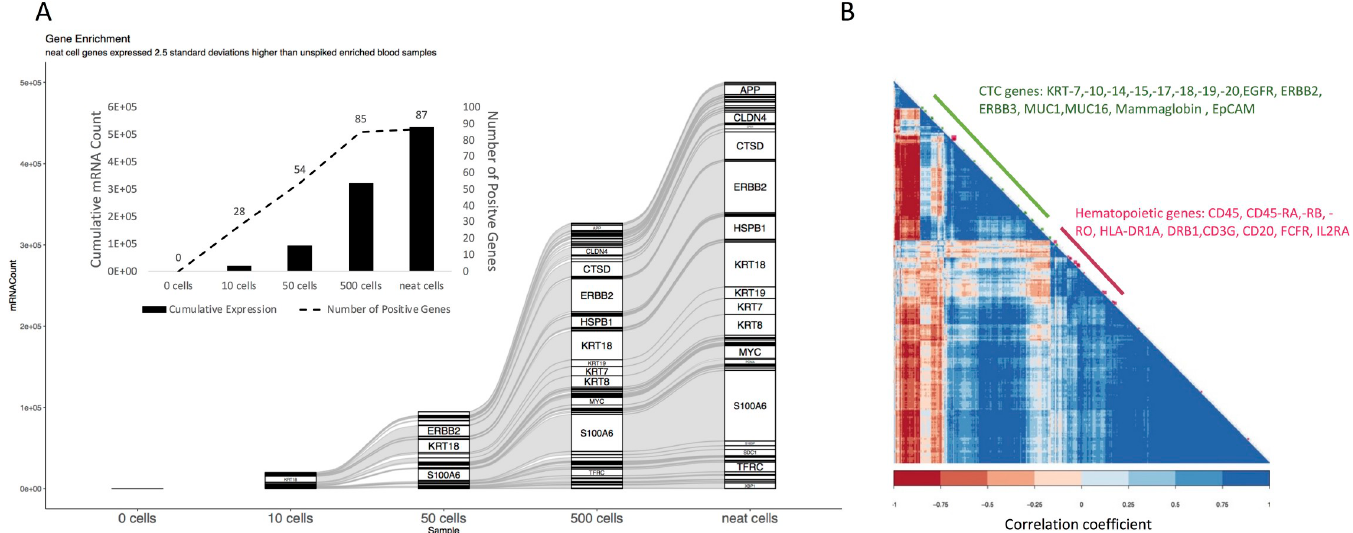
Fig 4. Molecular profiling by HTG after Parsortix PR1 enrichment. Healthy donor blood spiked with 0, 10, 50, or 500 SKBR3 cells was subjected to gene expression profiling with the HTG EdgeSeq PATH assay. A sample of 500 neat SKBR3 cells, with no blood components, was used as a control. A) Expression levels as mRNA counts per million reads are shown for each gene expressed at levels 2.5 standard deviations higher than in the sham-spiked enriched samples. Epithelial genes including ERBB2 and KRT18 are expressed by neat SKBR3 cells and are decreasingly common as the number of cells spiked into blood decreases prior to Parsortix PR1 enrichment and HTG assessment. The insert shows the cumulative transcript counts and total number of genes from the SKBR3 signature above the cut-off for each sample. B) Heatmap of Pearson correlation analysis shows that epithelial genes and hematopoietic genes are generally clustered as disparate groups and are inversely related.